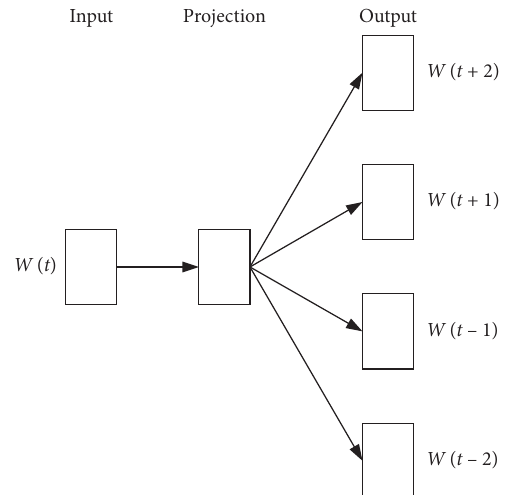
Figure 1: Schematic diagram of skip-gram model structure.